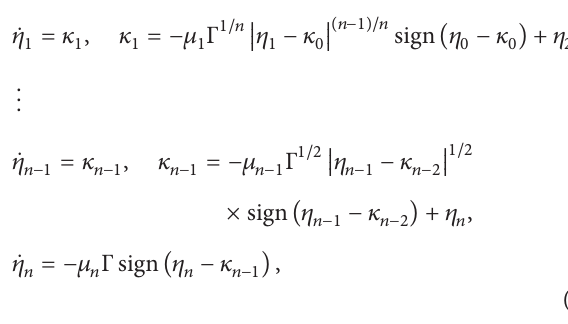
Table 2: Piezoelectric material’s dimensions and